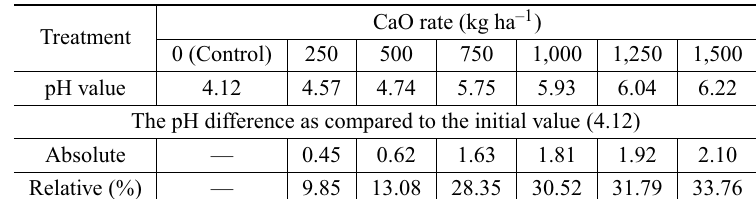
CaO treatments (kg ha –1 ) and changes in the soil